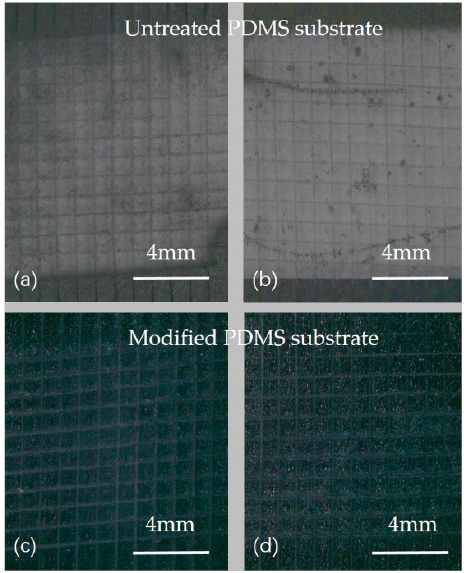
Figure 5. Photographs of the specimens after the crosscut tape test. ( a , b ): The MoS 2 sputtered on PDMS substrate without oxygen plasma treatment was almost completely detached; ( c , d ): The MoS 2 sputtered on oxygen plasma treated PDMS substrate was intact.